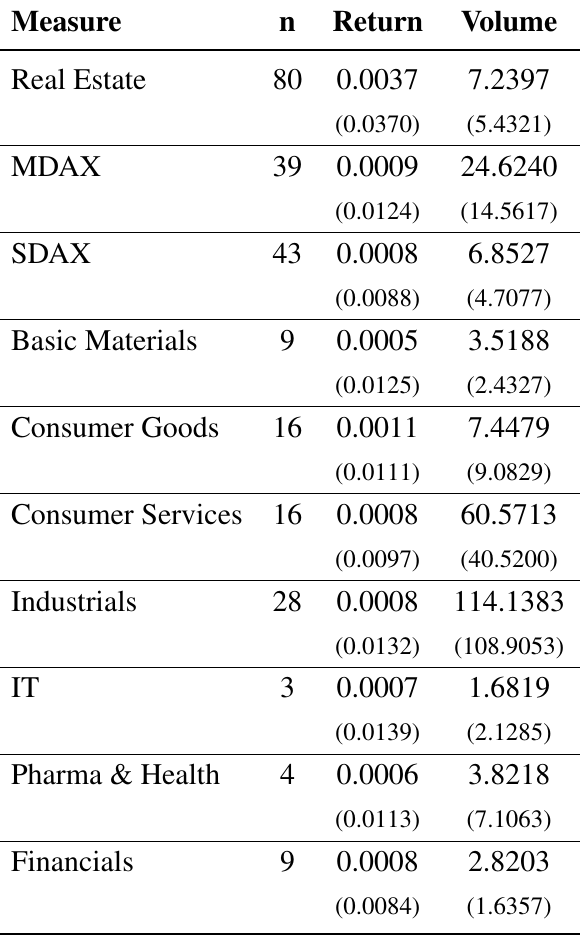
Table 1. Descriptive statistics